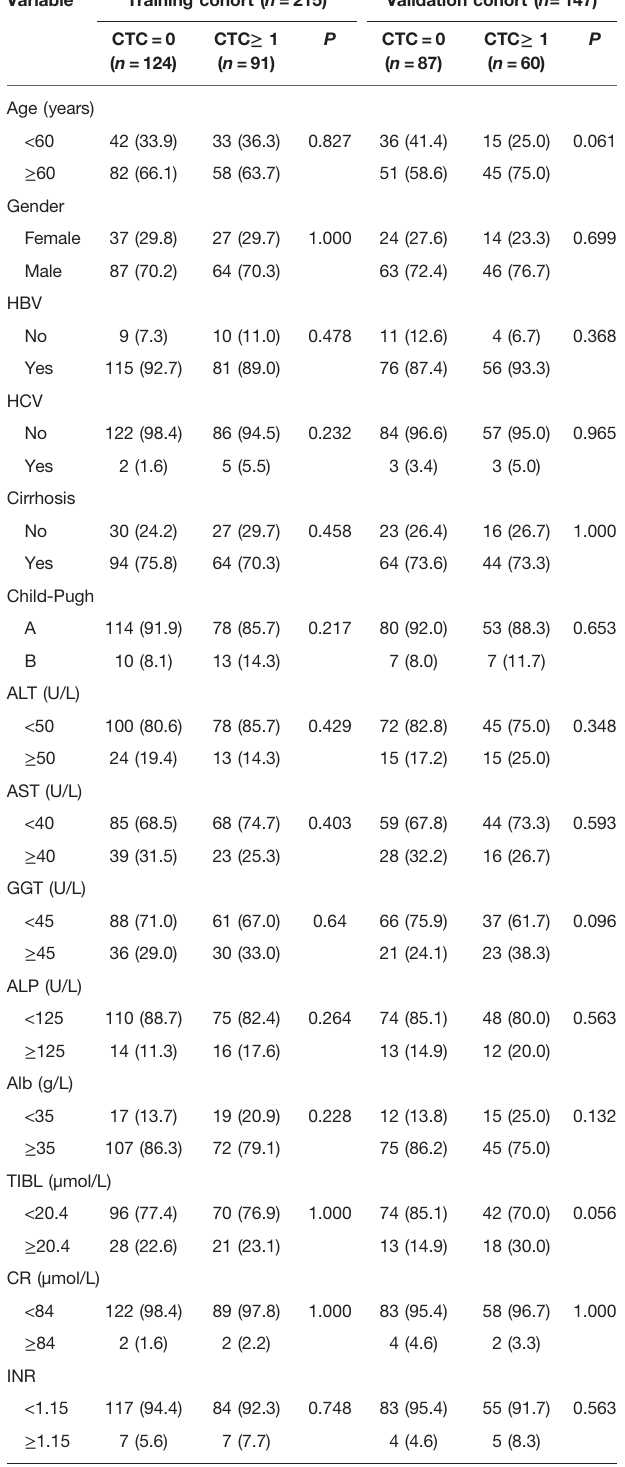
TABLE 5 | Relationship between CTC status with clinical characteristics for patients in the surgery group. Variable Training cohort ( n